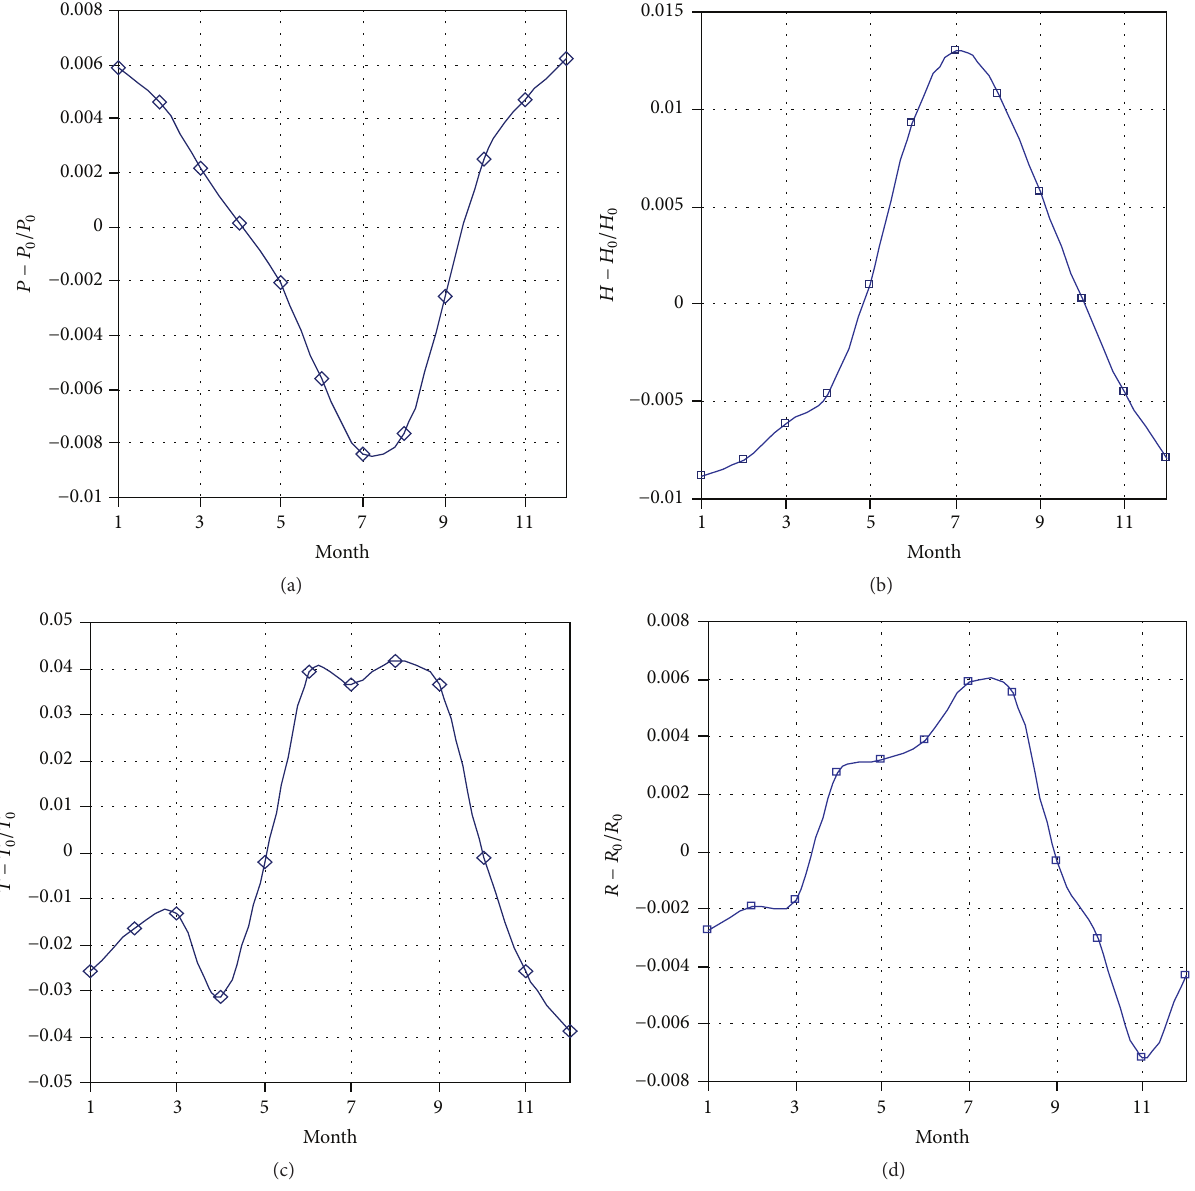
Figure 2: Monthly variations in (a) atmospheric pressure, (b) level of maximum production, (c) temperature at that level, and (d) muon counts, from their 11-year mean